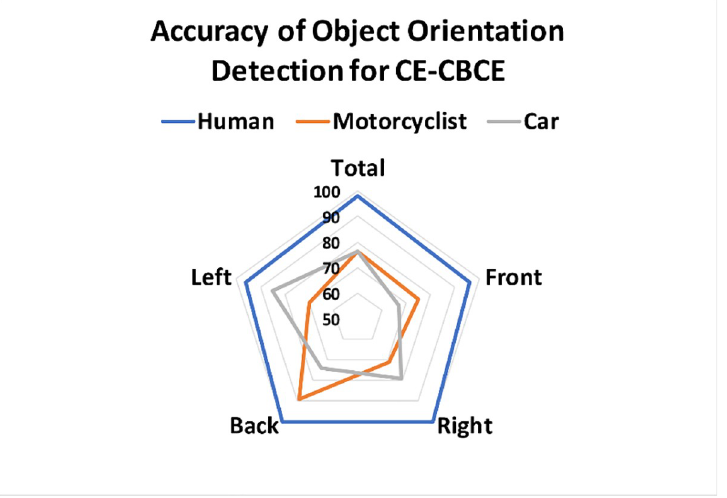
Fig 8. Accuracy results of CE-CBCE for each orientation.